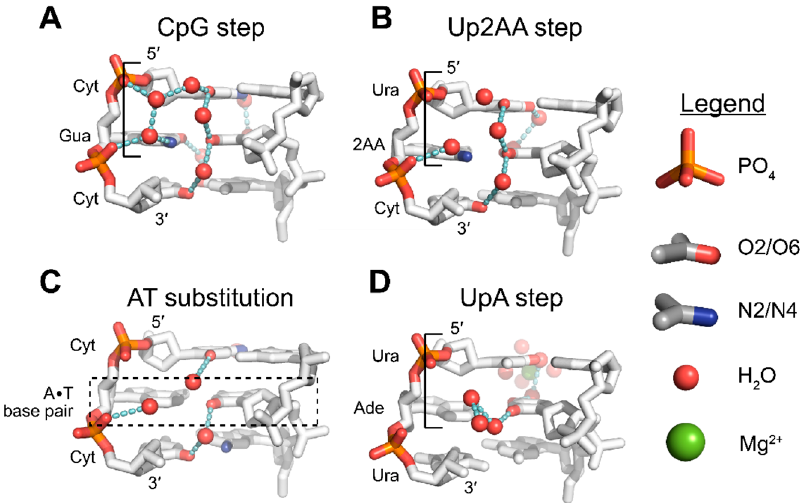
Figure 6. Hydration patterns of non-CG Z-steps as a comparison to the CpG step. Hydration patterns around different DNA sequences as they compare to the d(CpG) step. Water molecules are colored red with dashed lines representing hydrogen bonding networks. ( A ) Common hydration patterns of the reference d(CpG) step (PDB: 1ICK [70]) as mentioned above. ( B ) Presence of N2 substituent group in the d(Up2AA) step (PDB: 1D76 [47]) partially maintains hydration within the minor groove. On the major groove surface, consecutive O4 atoms are linked by similar water-bridging interactions seen between consecutive N4 atoms in the CpG step; however, the water bridging the O6 atoms of the adjacent dinucleotide step is absent. ( C ) Substitution of a single G • C base pair with A • T (shown within the dashed box), results in a CA · TG step and only partially disrupts hydration (PDB: 181D [31]). ( D ) Demethylation of dT bases to dU in d(UpA) steps (PDB: 1D41 [30]) results in the reordering of water molecules within the minor groove, but the hydration pattern is different from what is typically seen in d(CpG) sequences. Outer sphere coordination of a magnesium cation facilitates the two-water bridge between consecutive O4 atoms.